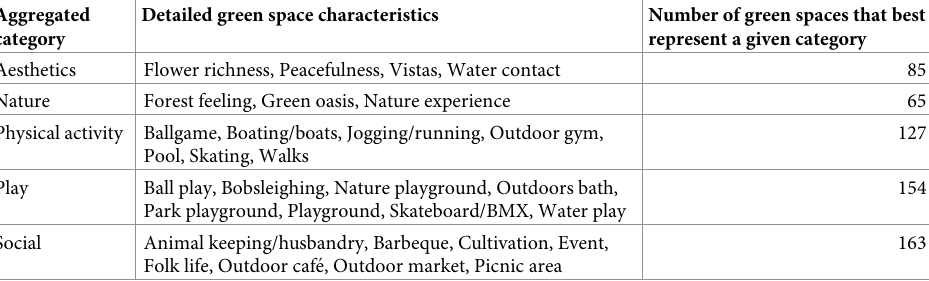
Table 1. Aggregation of characteristics recognized in